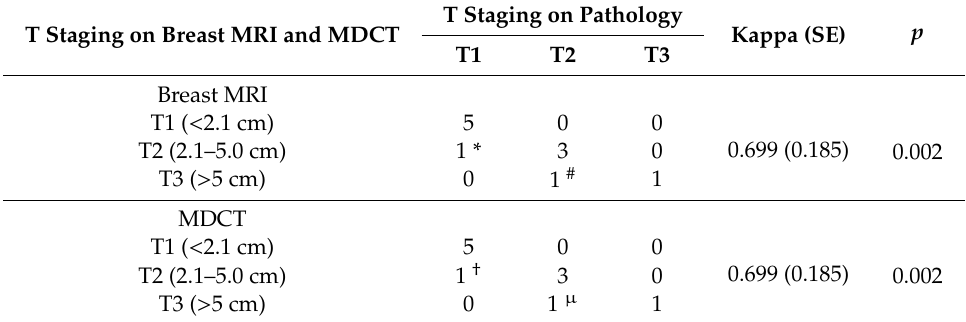
Table 2. Comparison between T staging evaluated by breast MRI and MDCT with pathology ( n = 11). T Staging on Pathology T Staging on Breast MRI and MDCT